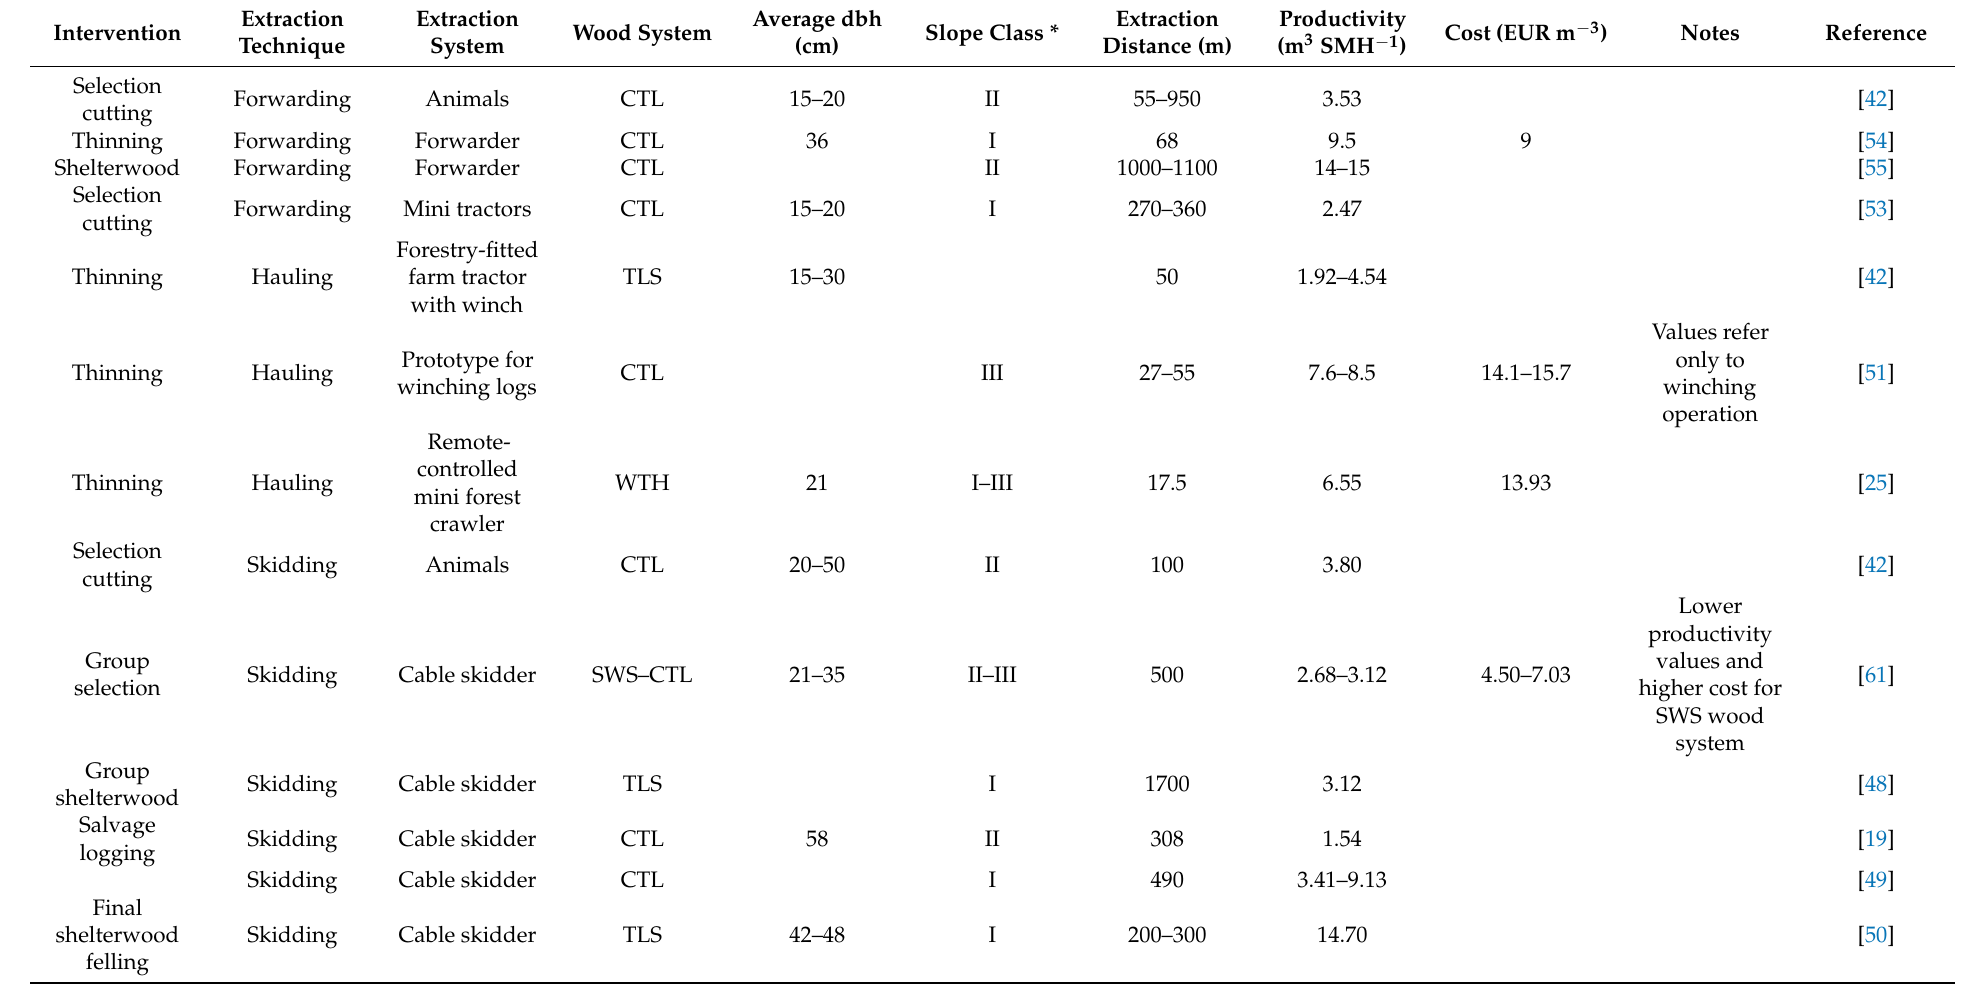
Table 2. Summary of data from the reviewed studies dealing with extraction operation. Empty cells indicate that that parameter was not immediately retrievable from the given